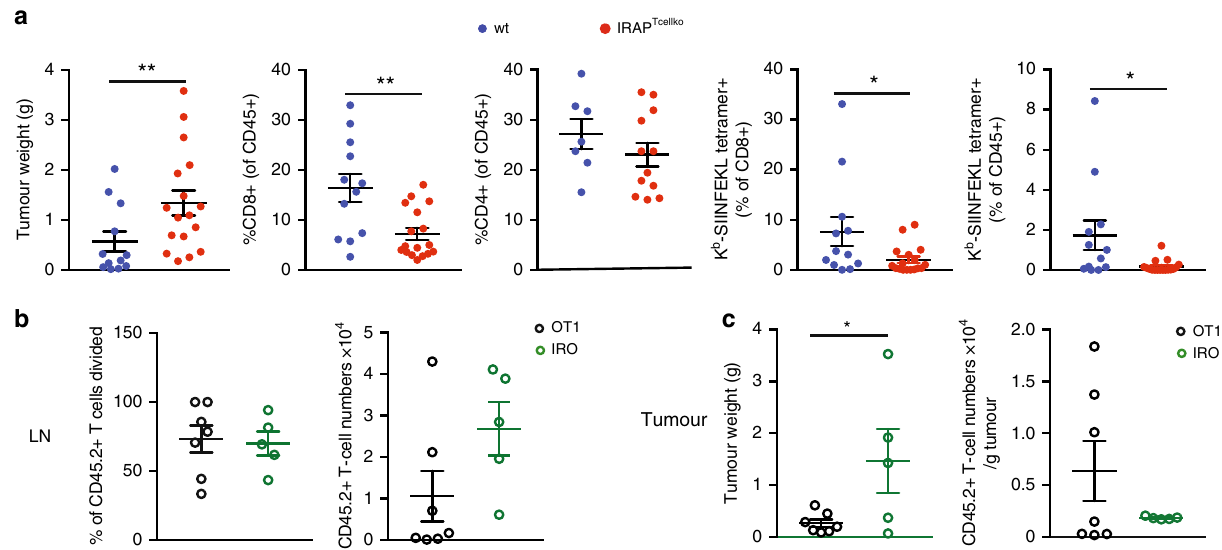
Fig. 7 IRAP is required for anti-tumour T-cell response. a Wt or IRAP Tcellko mice were injected s.c. with EG7-ova cells, and 12 – 14 days later, tumour weight and CD8 + T-cell response in the tumour were measured. Each dot represents a mouse. Values represent mean ± SEM of pooled results from three independent experiments. (Wt: n = 13 (except for graph, 3 where n = 7, IRAP Tcellko : n = 16 (except for graph 3, where n = 12). Graphs 1: ** p = 0.0041, 2: ** p = 0.0018, 4: * p = 0.0466, 5: * p = 0.0247). b , c CD45.1 C57BL6 mice were injected s.c. with EG7-ova cells, and 10 – 11 days later, 3 × 10 6 CTV-labelled OT1 or IRO T were injected i.p. The divisions of transferred T cells and their absolute numbers were evaluated after 6 days in the lymph nodes (LN) ( b ). The tumour mass and the numbers of T cells in fi ltrating the tumour were analysed 6 days after T-cell transfer ( c ). Each dot represents a mouse. Values represent mean ± SEM of pooled results from two independent experiments (OT1: n = 7, IRO: n = 5, * p = 0.0440). All p -values were calculated with two- tailed unpaired t tests. For additional information, see Supplementary Fig.